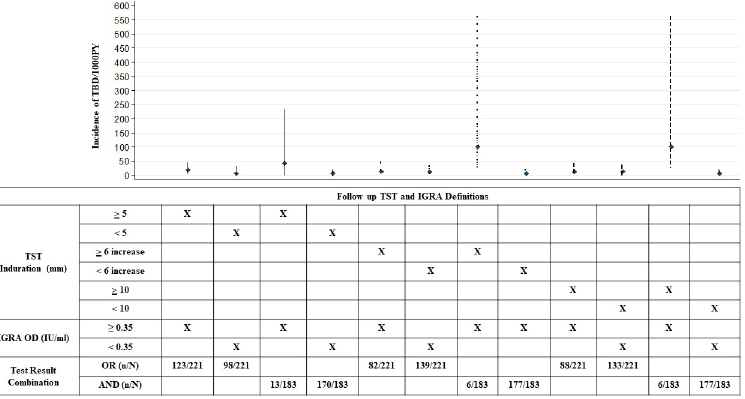
Fig 4. Incident TB disease rates among household contacts with and without incident TB infection. A line graph depicting the incident TB disease (iTBD) rates among household contacts (HHC) of adult pulmonary TB (PTB) patients in India, stratified by incident TB infection (iTBI) status which was defined using different TST conversion cut offs ( � 5 mm, � 10 mm, and � 6 mm increase in induration from previous reading) along with the IGRA conversion cut off of � 0.35 IU/l. The comparison shows that the iTBD estimates were similar for those HHC with and without iTBI, irrespective of the TST or IGRA cutoffs used to define iTBI. In addition, the iTBD estimates were similar irrespective of whether the definition of iTBI was based on the requirement of both a positive TST and IGRA test (“AND”) or either test alone (“OR”).